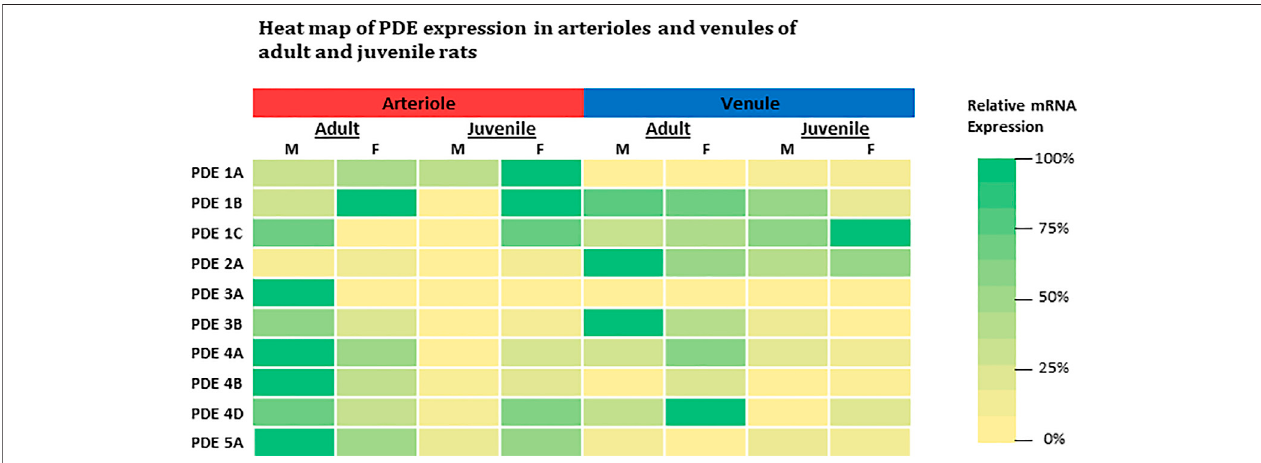
FIGURE 3 | Heat-map comparison for expression levels of PDE1-5 in both arterioles and venules across adult and juvenile male and female rats. For each gene, expressionlevelwascomparedacrossallmicrovesselsregardlessofitsorigin(age,sex,andmicrovesseltype)bynormalizingeachexpressionleveltothehighestmRNA level (2 − ΔΔ Ct , where ΔΔ Ct (cid:2) Δ Ct each – Δ Ct highest ). The color is de fi ned as the highest expression level in green (100%) and the lowest in yellow (0%). M: male; F: